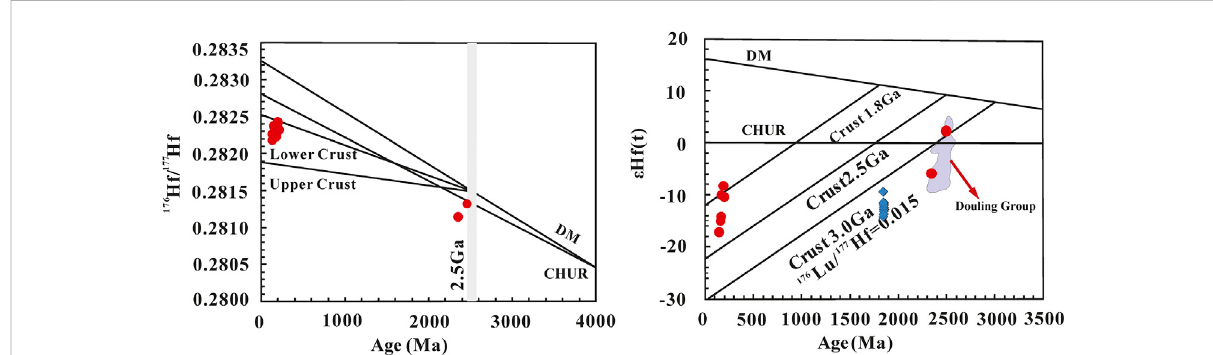
FIGURE 11 Zircon Hfisotopevs.age(Ma). CHUR-chondriticuniform reservoir; DM-depleted mantle.The bluerhombus squares representtheamphibolite of the Yudongzi group (Chen et al., 2019). The Douling group (Hu et al., 2013; Wu et al., 2014) in the previous study is used for comparison.